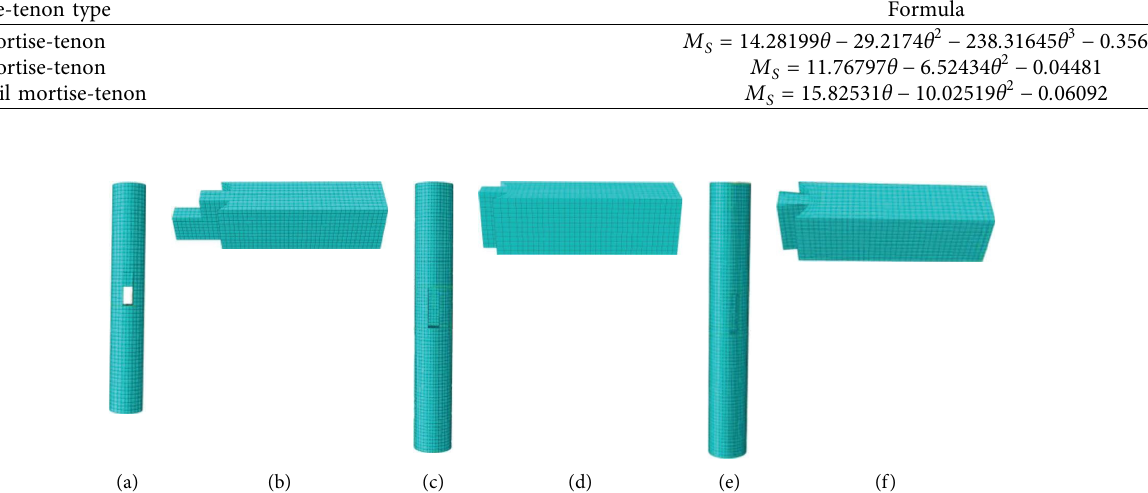
Figure 16: Element meshing: (a) Tou mortise-tenon column. (b) Tou mortise-tenon beam. (c) Ban mortise-tenon column. (d) Ban mortise- tenon beam. (e) Dovetail mortise-tenon column. (f) Dovetail mortise-tenon